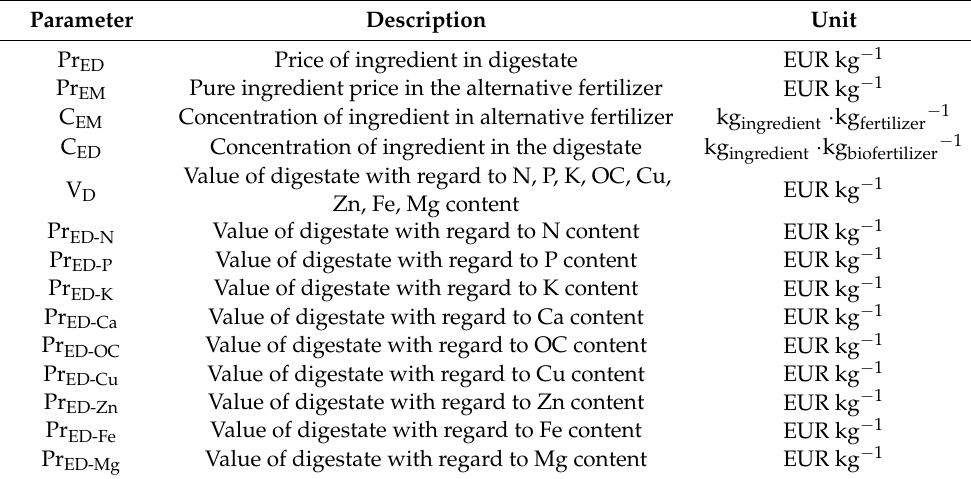
Table 1. The description of the parameters and variables followed by units used for digestate value